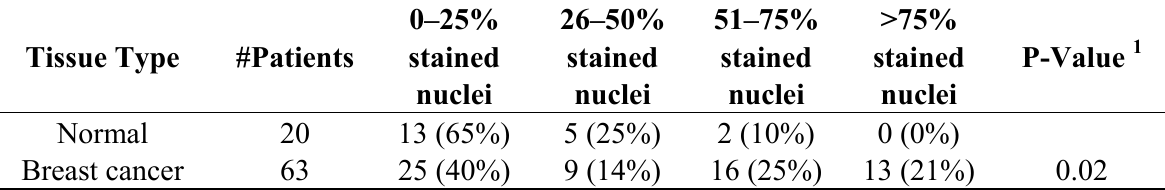
Table 2. CENPA staining by tissue type.